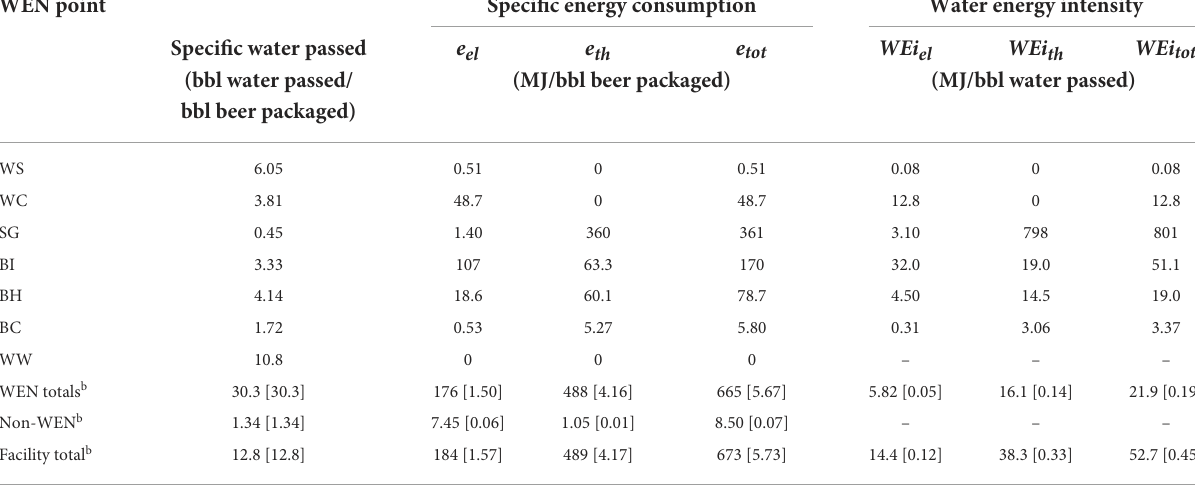
TABLE 2 Specific energy consumption (e) and water energy intensity (WEi) of brewery WEN points a . WEN point Specific energy consumption Water energy intensity Specific water